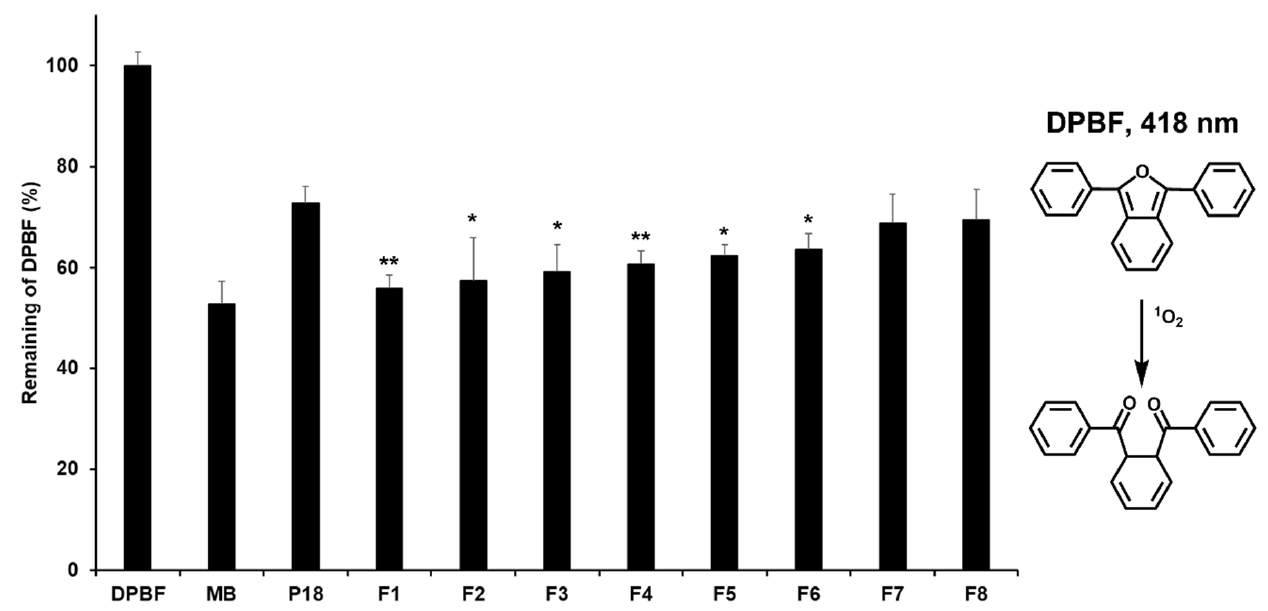
Figure 8. Study of DPBF (50 μ M in DMSO) absorbance decay (%) for determining the 1 O 2 photogeneration efficacy of P18 with/without SLNs at 418 nm, after photoirradiation (total light dose, 2 J/cm 2 ; irradiation time, 15 min). Results are expressed as means ± standard deviations of three independent experiments ( n = 3). Negative control: DPBF (1,3-diphenylisobenzofuran); positive control: MB (methylene blue); P18 (purpurin-18). Statistical significance of the difference in DPBF absorbance between pure P18 solution and the formulations was determined using one-way analysis of variance and Student’s t -tests and is indicated by either a single asterisk ( p < 0.05) or double asterisks ( p < 0.01).